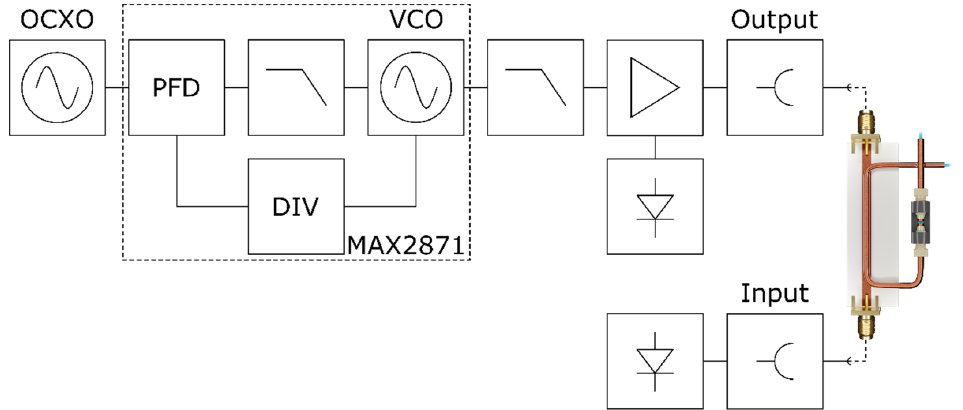
Figure 3. Block diagram of the developed new readout electronics, consisting of an oven-controlled oscillator (OCXO), the Analog Devices MAX2871 integrated PLL/VCO chip, an adjustable low-pass filter for filtering the harmonics, and an adjustable amplifier for the output. Both the output signal of the excitation source (CaSRR input) and the transmitted output signal of the CaSRR are recorded with demodulators.